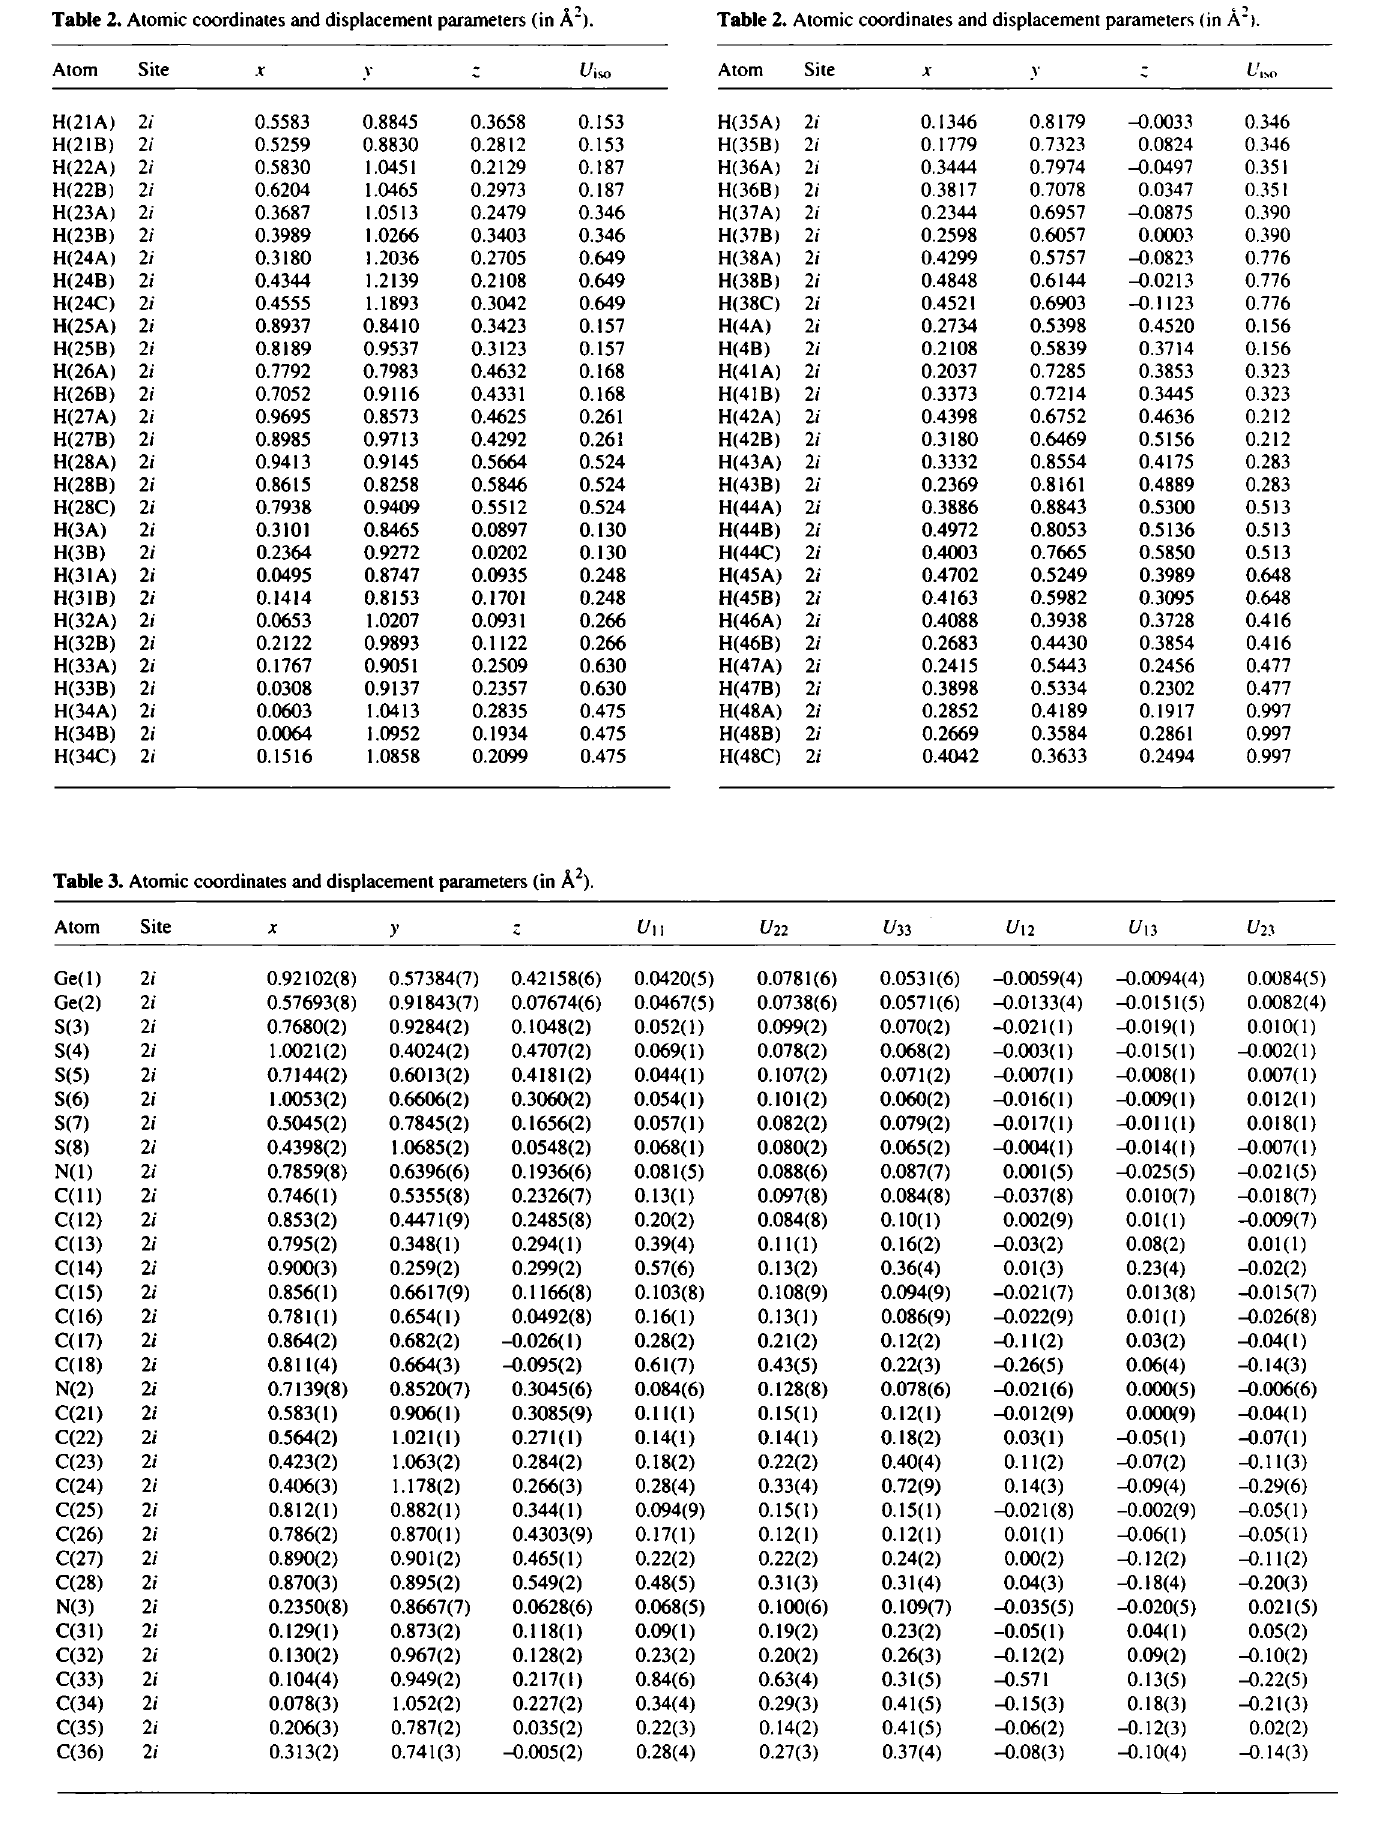
Table 2. Atomic coordinates and displacement parameters (in Ä 2 ).